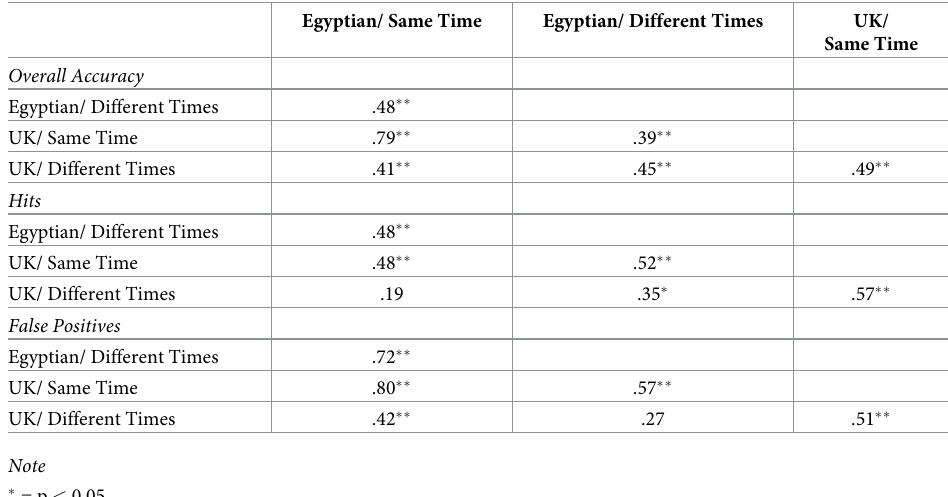
Table 5. Correlations among the four face-matching tasks in Experiment